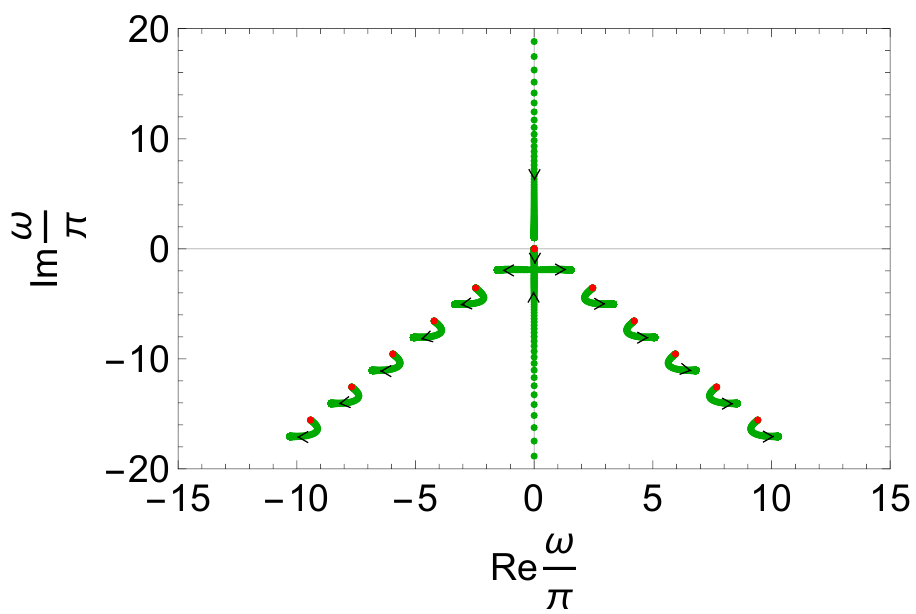
Figure 2 . Evolution of the homogeneous QNM poles with varying ˆ β on the complex ω plane. The red dots are the QNM frequencies for ˆ β = 0 . As ˆ β is increased from zero, the QNM frequencies follow the green trajectories and the black arrows denote direction of motion of QNM frequencies with increasing β until eventual